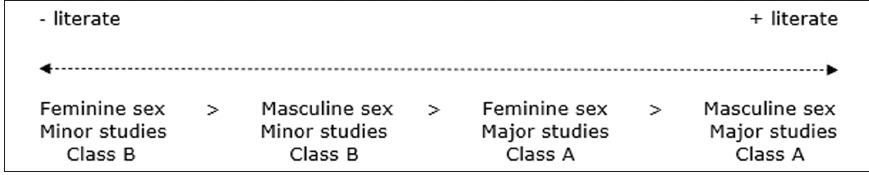
Figure 1: Literacy continuum based on the social clues. Source : Seixas (2020: